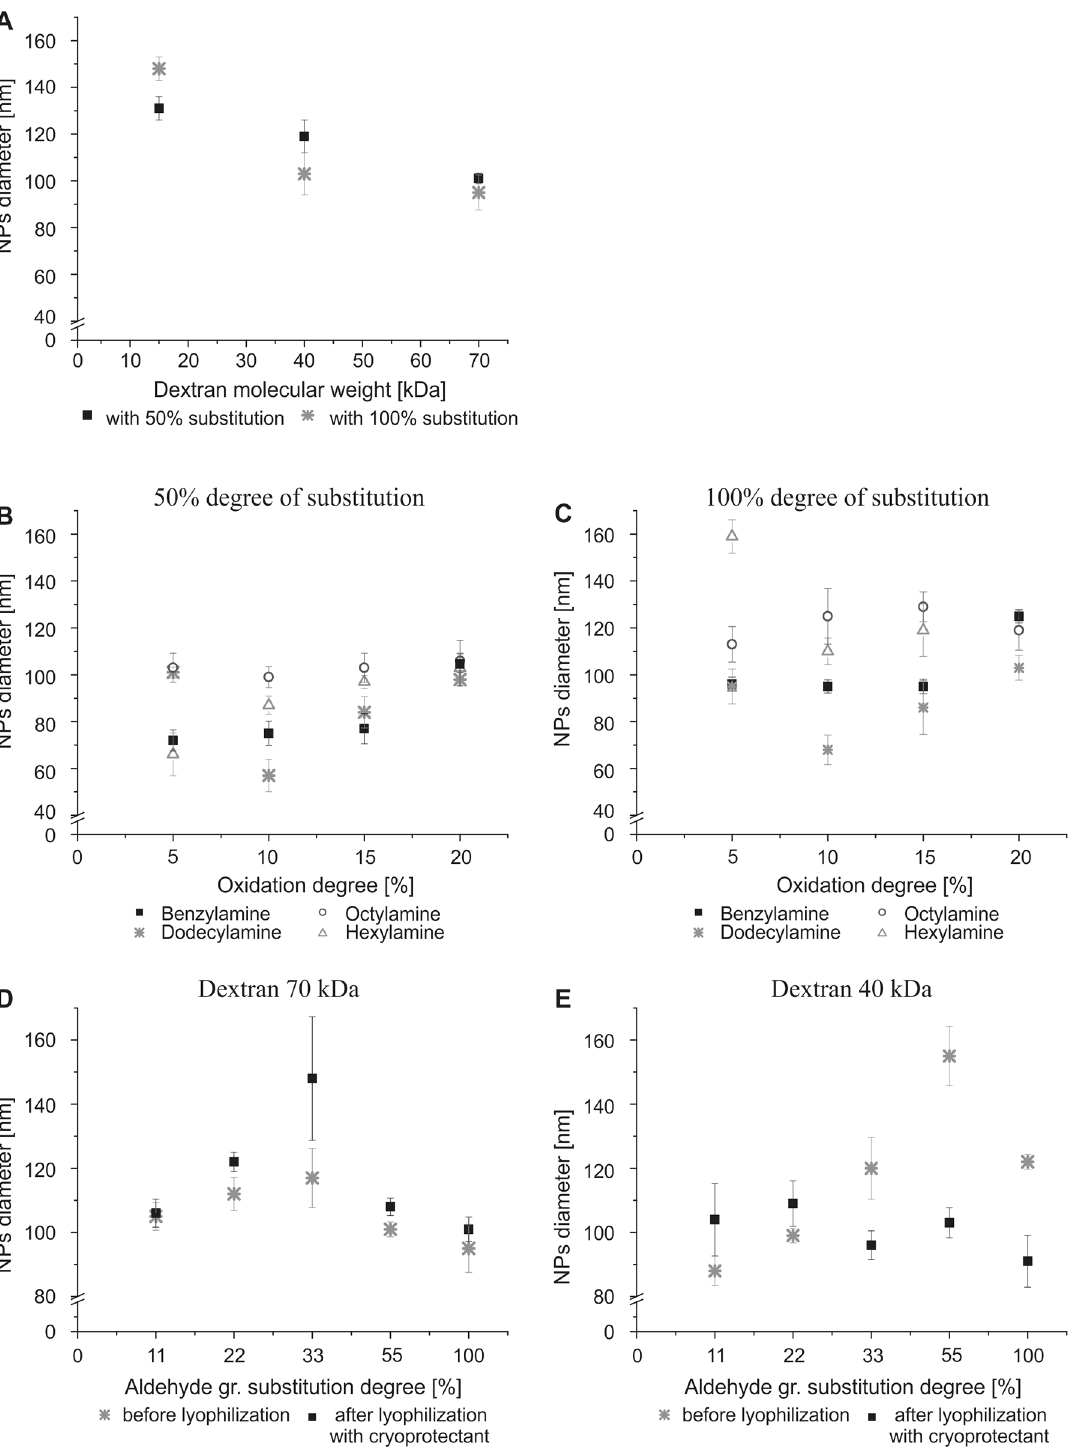
Fig 3. Influence of synthesis parameter modifications on Dex-NP diameter. (A) Diameter of Dex-NPs (non lyophilized) synthesized from dextran with 15, 40, and 70 kDa molecular weights and 50% and 100% degrees of substitution, dodecylamine as a coiling agent, 5% oxidation degree. Dextran with 70 kDa and (B) 50% degree of substitution and (C) 100% degree of substitution with various coiling agents. Percentage of degree of substitution of dodecylamine on (D) 70 kDa dextran; 5% oxidation degree and (E) 40 kDa dextran; 5% oxidation degree. Mean n = 3 ± SD.